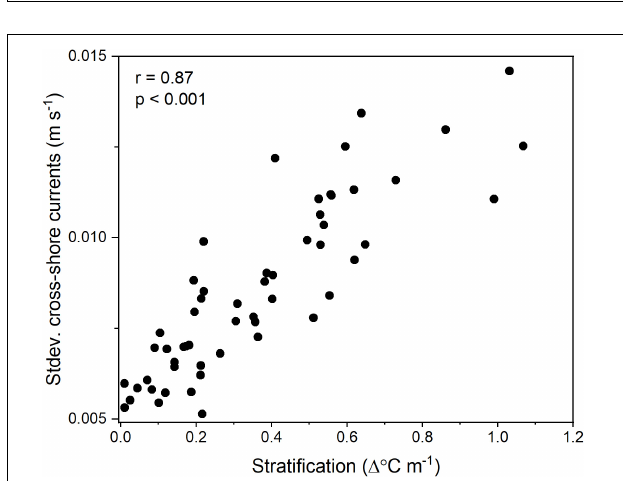
FIGURE 9 | Relationship between mean ( ± SE) thermal stratification and estimated C. fissus cross-shore larval transport for each cruise (numbers 1–5). Positive values represent onshore (eastward) larval transport.